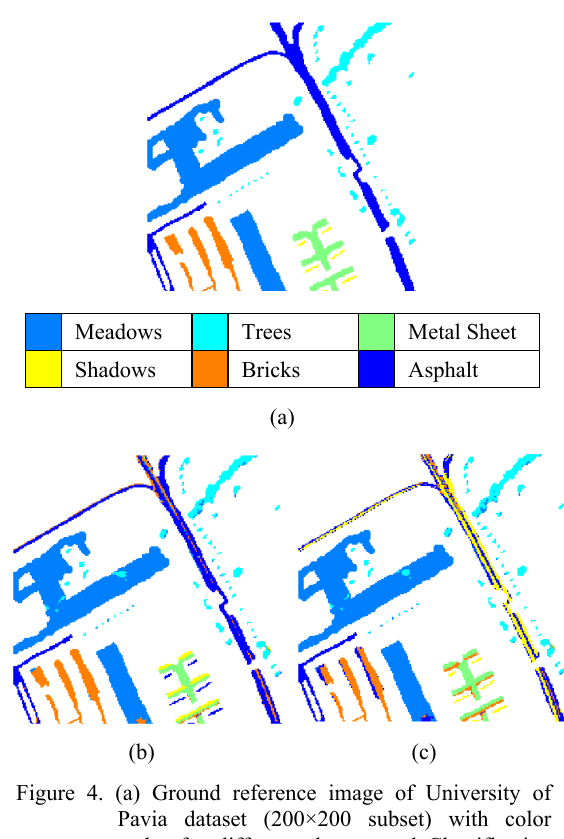
Figure 4. (a) Ground reference image of University of Pavia dataset (200×200 subset) with color codes for different classes, and Classification maps obtained by (b) ORCLUS, (c) KM-SPCA.